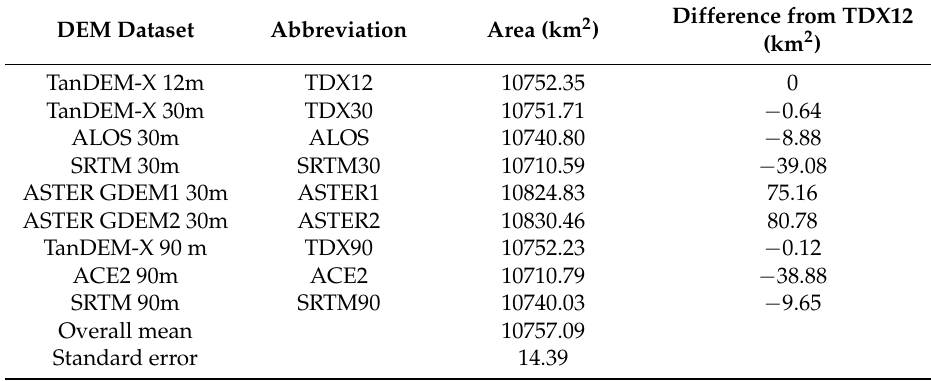
Table 1. Full catchment delineation area and difference from TDX 12 m baseline. All delineated catchments areas are so close to the TDX12 baseline that the average is a mere 5 km 2 different for a more than 10,000 km 2